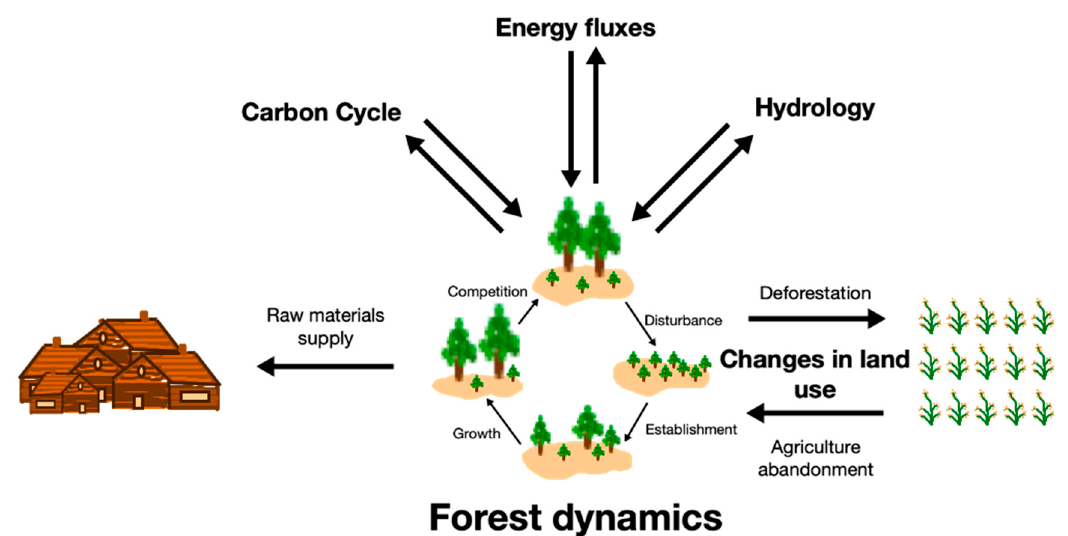
Figure 3. Schematic representation of the main biophysical and biogeochemical processes in terrestrial ecosystems (adapted from [89] ).